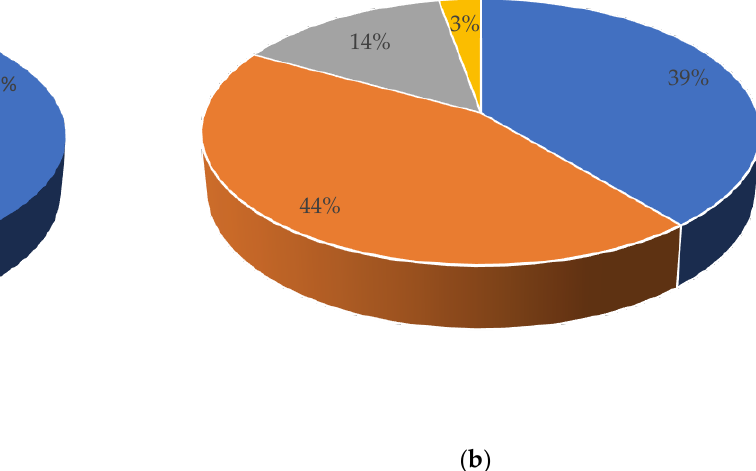
Figure 2. Comparison of optimised planting structures obtained under ( a ) cooperative and ( b ) competitive game mechanisms.